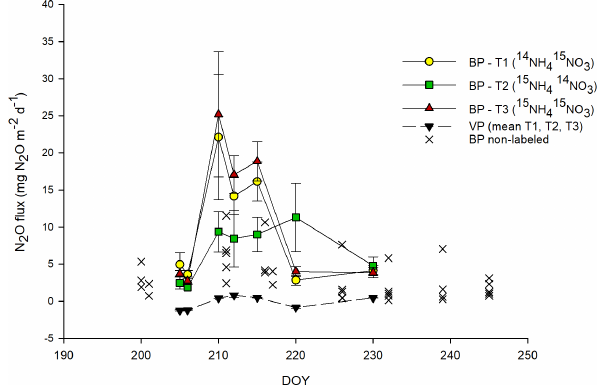
Figure 1. Total N 2 O fluxes from labeled plots. For bare peat (BP) soils (in color), N 2 O fluxes are mean values ± SE ( n = 3) for each treatment; for vegetated peat (VP) soils (black triangles), the mean N 2 O flux of three plots and three treatments is shown. For comparison, N 2 O fluxes from BP non-labeled plots ( × ) located nearby are also shown (long-term experiment; permanent cham- bers, multiple sampling points). The abbreviations used in the fig- ure are as follows: DOY – day of the year, T1 – Treatment 1 ( 14 NH 4 15 NO 3 ), T2 – Treatment 2 ( 15 NH 4 14 NO 3 ) and T3 – Treat- ment 3 ( 15 NH 4 15 NO 3 ). Error bars for VP data points are smaller than the